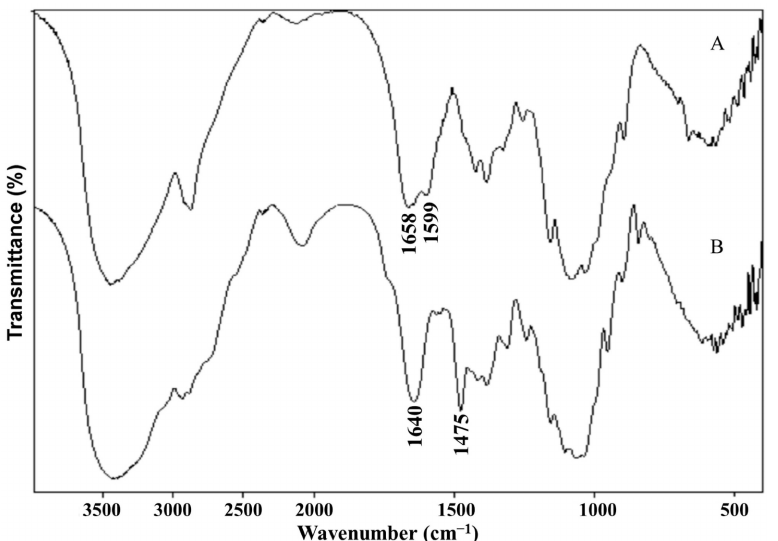
Figure 2. IR spectra of samples prepared in KBr pellets. ( A ) Chitosan (CS) and ( B ) N -trimethyl chitosan